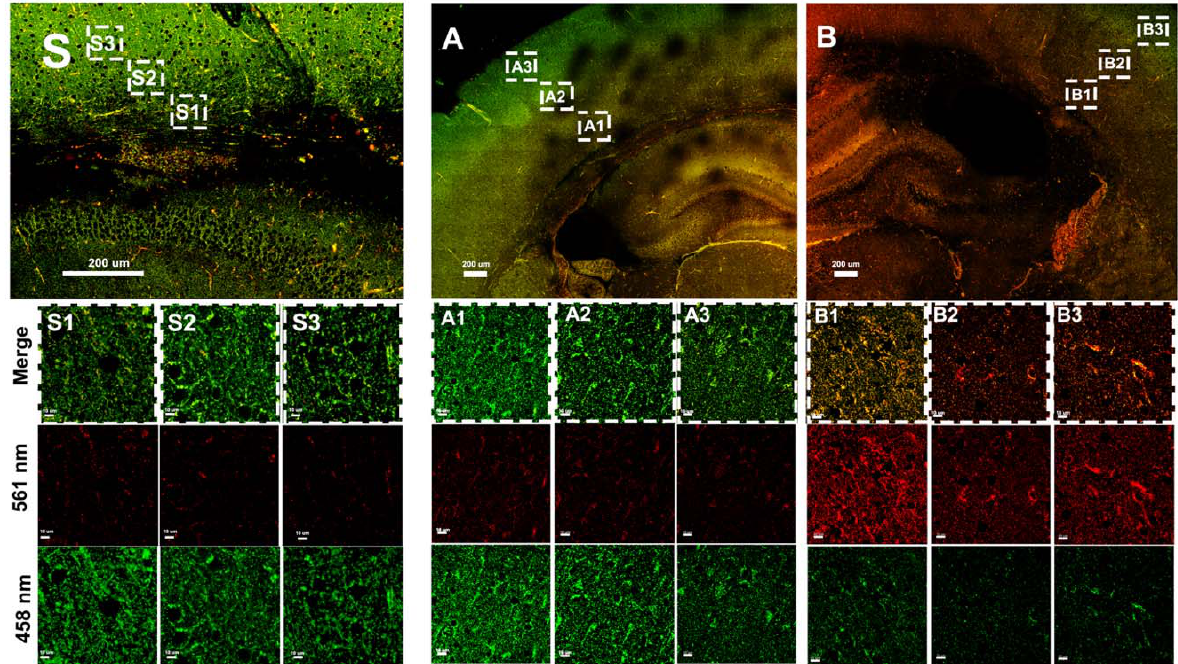
Figure 3. Assessment of mitophagy 3 h after HI in the brain tissue of mt-Keima mice by super- resolution microscopy; (( A ), A1–A3) uninjured (contralateral) hemisphere; (( B ), B1–B3) injured (ipsilateral) hemisphere; serial sections are visualized at 100 µ m intervals (indicated in dashed rectangles) of both hemispheres and the in control (( S ), S1–S3). The Keima protein changes color depending on the pH environment when being transferred from an autophagosome (green) to a lysosome (red). The mt-Keima protein is stable in lysosomes, and the excitation peak of mt-Keima shifts from 458 nm “green” to 561 nm “red” upon lysosome delivery, indicating mitophagy activation and delivery of mitochondria to